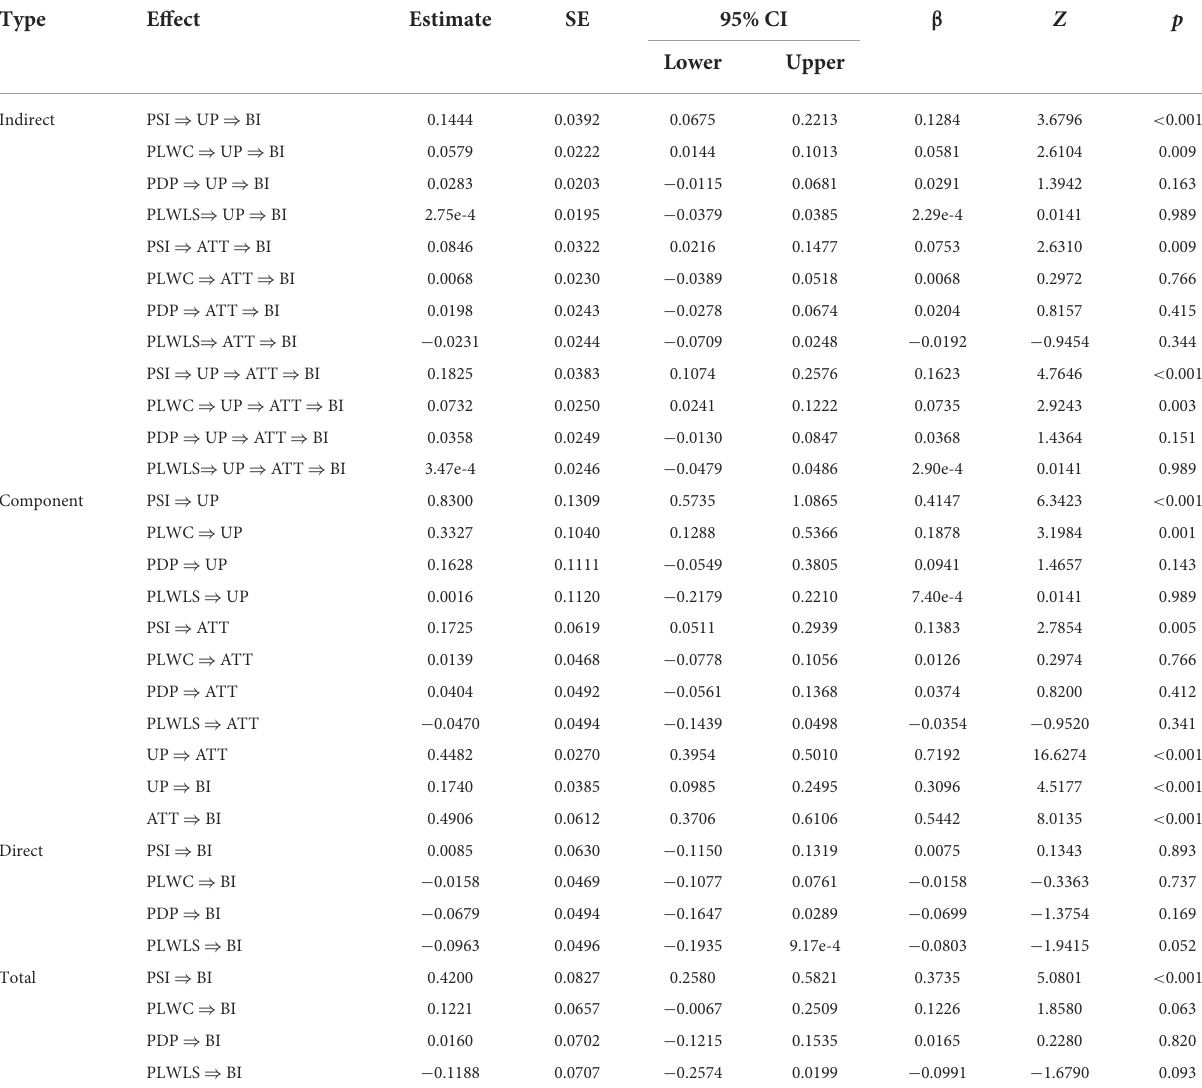
TABLE 5 Results of the mediation